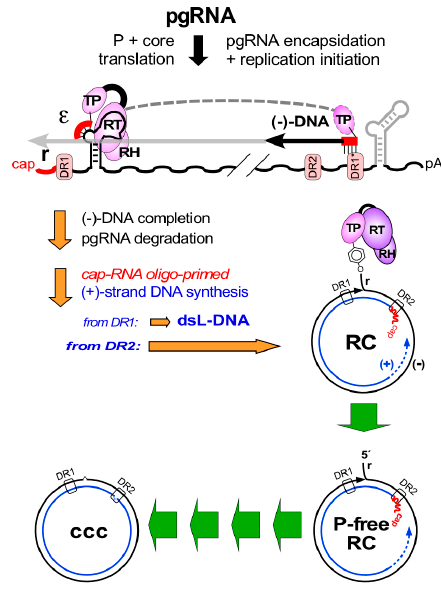
Figure 3. The hepadnaviral genome life-cycle. Protein-primed reverse transcription is initiated by P protein binding to the ε stem-loop on pgRNA, leading to a short ε -templated DNA oligo whose 5 ′ terminal nt is covalently linked to a Tyr residue in P protein’s terminal protein (TP) domain. Translocation to an acceptor at DR1* allows its extension into slightly overlength minus-strand DNA (carrying the ”r” redundancy), with concomitant pgRNA degradation, except for the capped 5 ′ terminal end that serves as plus-strand DNA primer. Direct extension from DR1 on yields double stranded linear DNA (dsL-DNA); RC-DNA formation requires primer transfer to DR2 plus an additional template switch (not shown). These steps establish the unusual features of RC-DNA, with non-DNA moieties on both 5 ′ termini, an overlength minus-strand and an incomplete plus-strand. For cccDNA formation, all peculiarities on RC-DNA must be fixed, both strands must gain exactly unit-length, and the ends must be ligated. The multistep nature of the process is symbolized by the multiple green arrows. One of the predicted intermediates is RC-DNA from which P protein has been released (P-free RC); whether this is the first intermediate as depicted is not known.